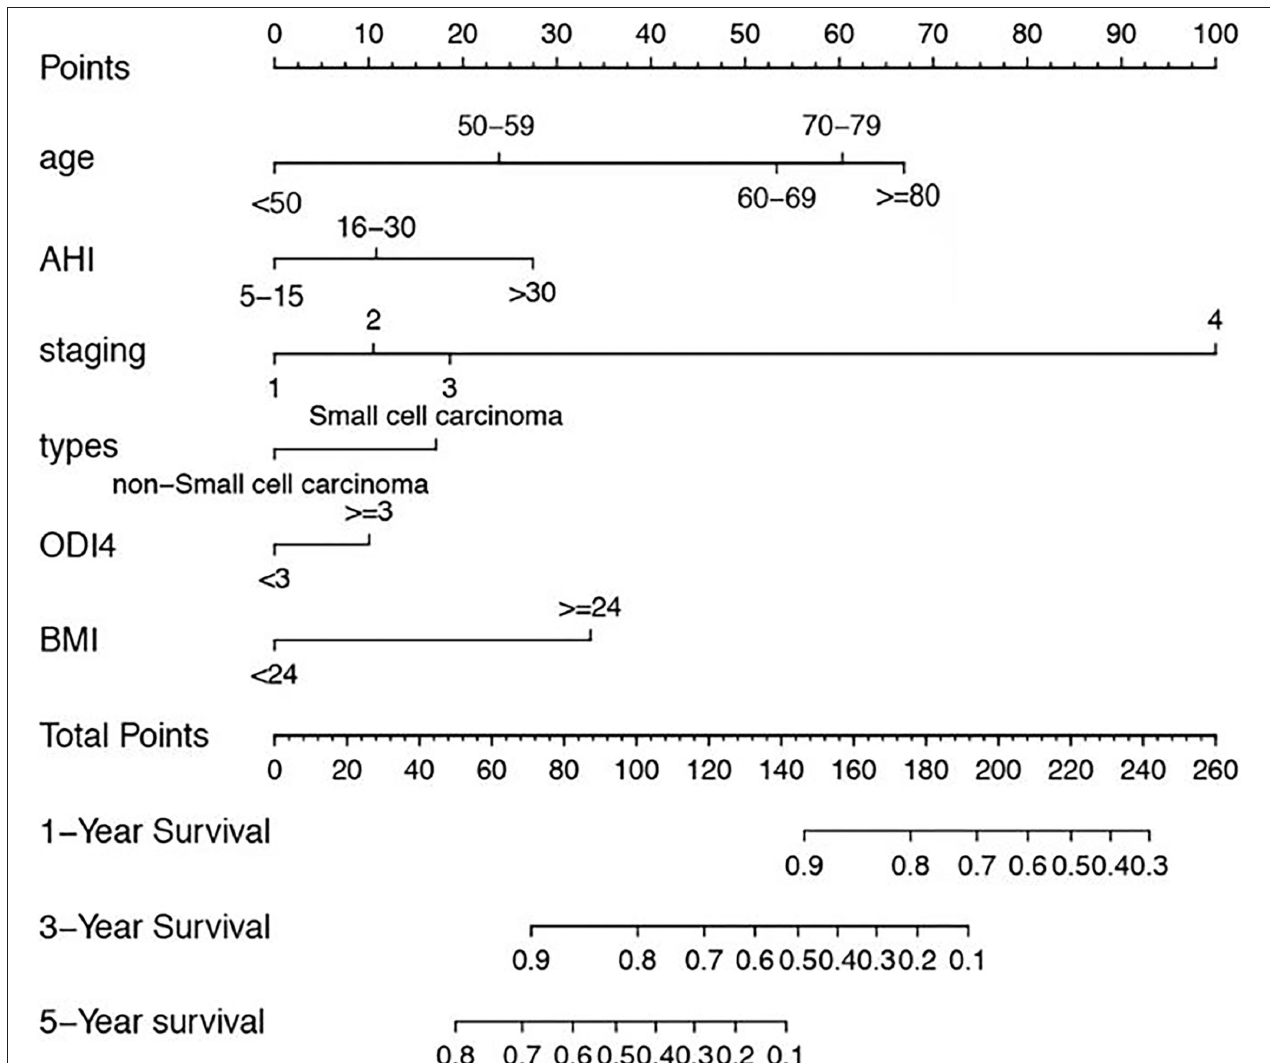
FIGURE 1 | Nomogram, including Age, AHI, TNM stage, types, BMI and ODI4 for 1, 3, and 5 years overall survival (OS) in lung cancer patients with OSA. The nomogram is valued to obtain the probability of 1, 3, and 5 years survival by adding up the points identified on the points scale for each